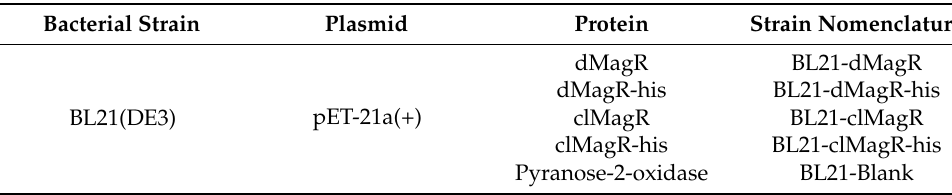
Table 2. Overview of recombinant E. coli strains used in this study. Bacterial Strain Plasmid Protein Strain